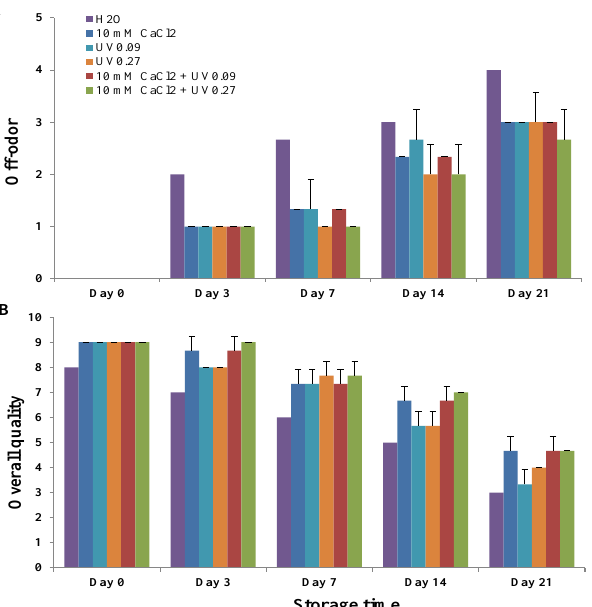
Figure 2. Effects of preharvest treatments on off-odor ( A ) and overall quality ( B ) of broccoli microgreens during cold storage (4 °C). UV0.09: 0.09 Wh/m 2 UVB; UV0.27: 0.27Wh/m 2 UVB. Data presented are the means of three replicates; vertical lines represent standard deviation.